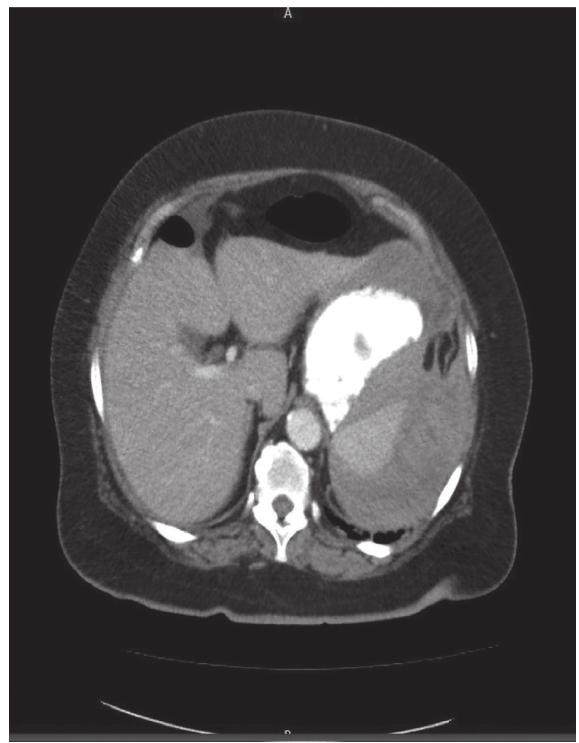
Figure 3: Axial CT scan, cross-section view, showing subcapsular hematoma of the